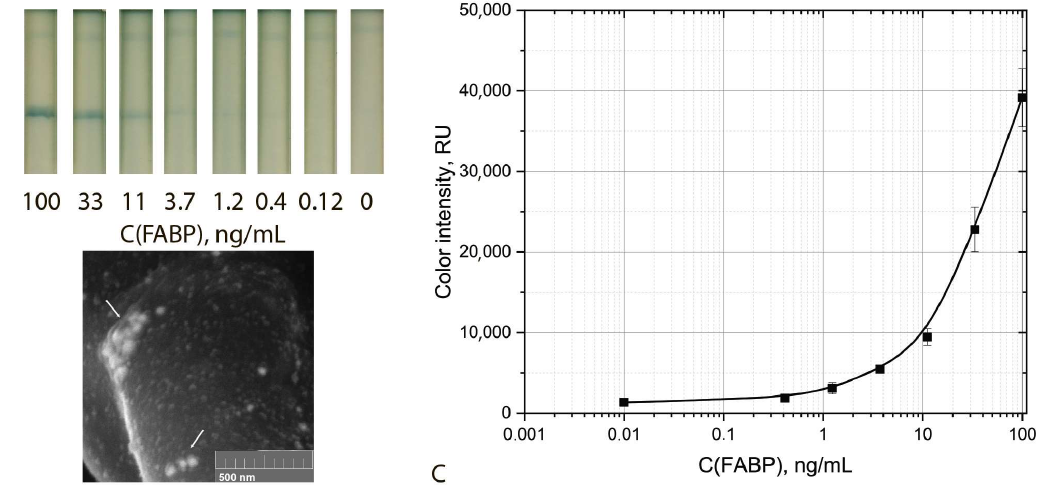
Figure 9. ICA with the use of GNFs aggregation: Appearance of test strips ( A ), SEM image of the sGNFs aggregates bound in the analytical zone ( B ) and calibration curve for FABP detection in serum ( C ) ( n = 5).